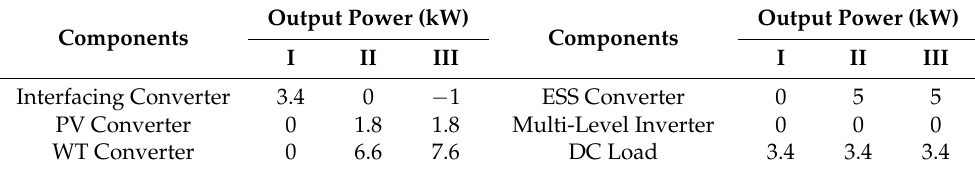
Figure 17. Experiment waveforms of PV converter and ESS converter in mode 2. Table 2. Output power of each power conversion devices in mode 2.